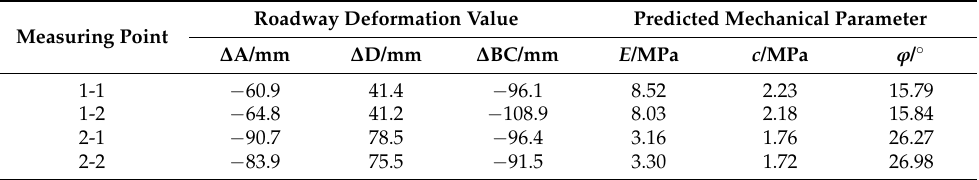
Table 6. The deformation and predicted mechanical parameters of